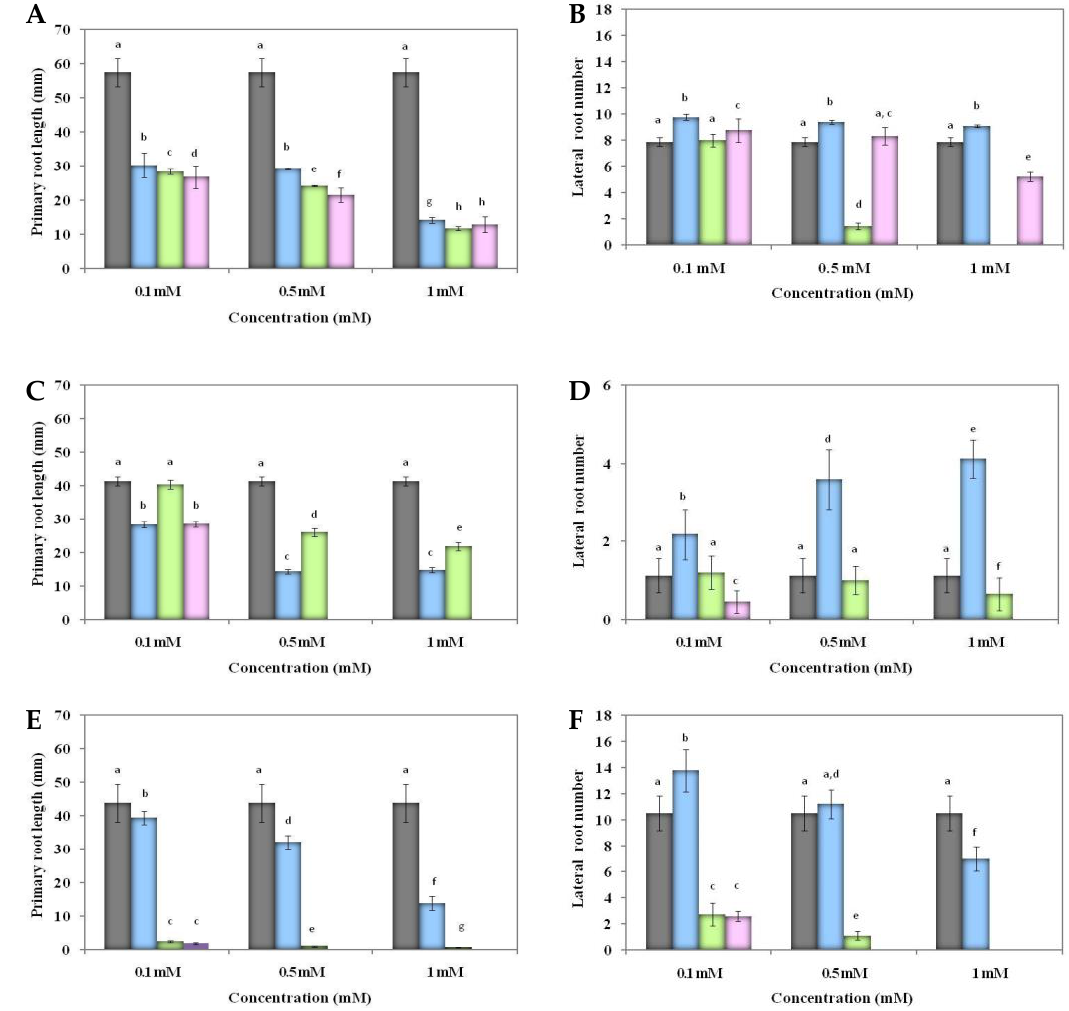
Figure 1. Effect of HEA- p ABA (ethanolammonium p -aminobenzoate; blue), HEA- p NBA (ethanolammonium p -nitrobenzoate; green), IAA (indole-3-acetic acid; pink) different concentrations and control (grey) on primary root length and lateral root number of C. sativus ( A , B ), S. lycopersicum ( C , D ) and A. thaliana ( E , F ). In all figures, different letters represent statistically Scheme 0. Metric bars indicate the standard error of the mean (SEM) of 5 repeated measurements.